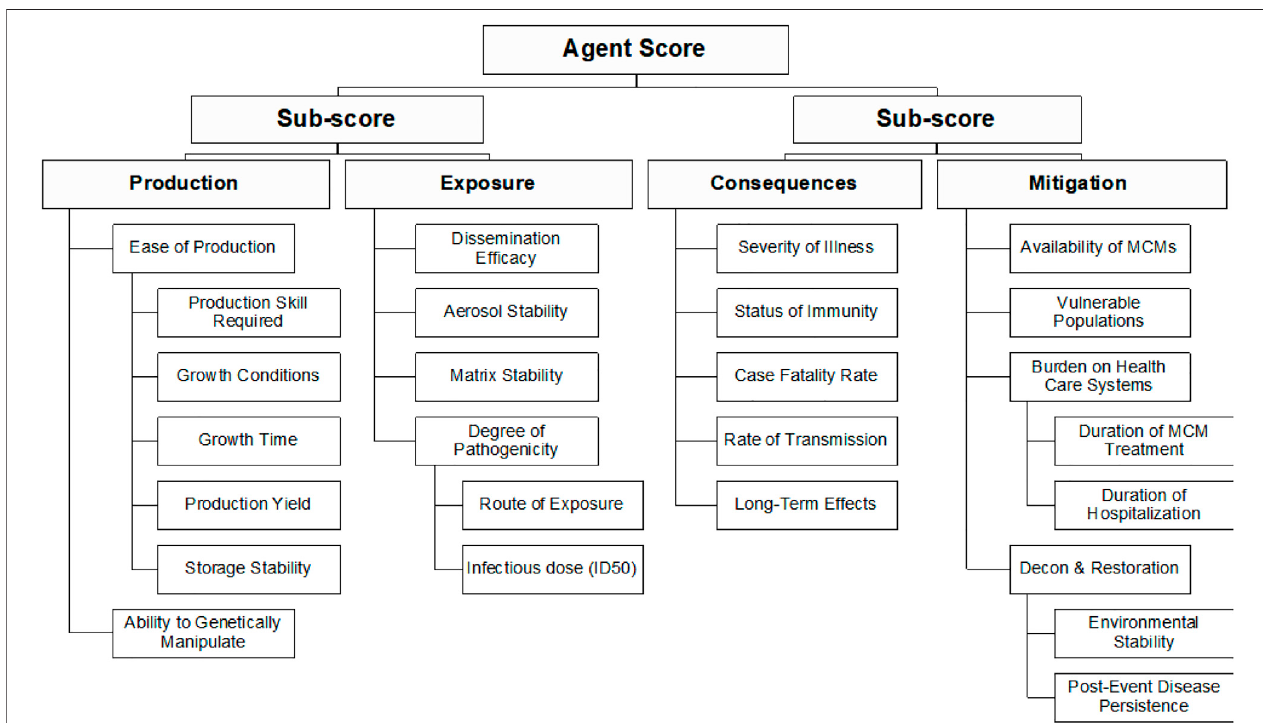
FIGURE 1 | Summary of the criteria and hierarchy captured in the MCDA framework and fact